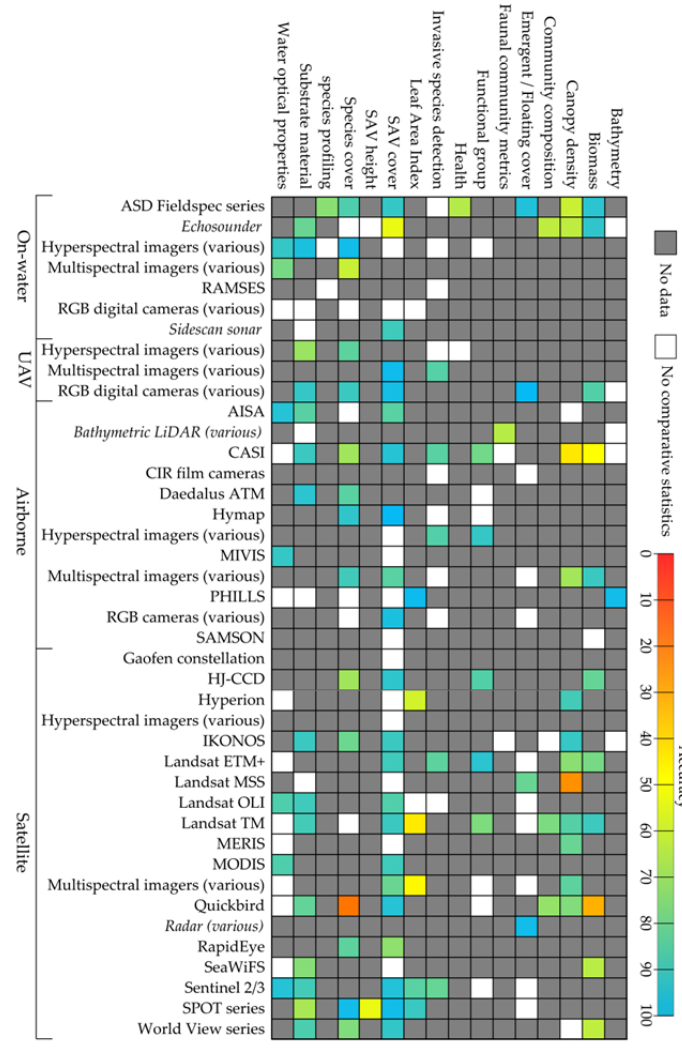
Figure 11. An illustration of the extent and accuracy of previous aquatic RS work regarding SAV. The maximum accuracy found (reported as percent overall accuracy or R 2 ) is depicted for each sensor-application pairing. Colored squares are on a gradient scale from 0 to 100, representing either percent overall accuracy or R 2 × 100. White squares indicate that the sensor-application pair was encountered but no suitable overall accuracy measure was provided. Grey squares indicate that no source employed that sensor-application pairing. The large number of white and grey squares respectively demonstrate the need for consistent accuracy reporting and the huge research gaps to date in aquatic RS. Active sensors are italicized. All sources cited in this text were reviewed in the compilation of the figure, as well as references [140 – 257] .